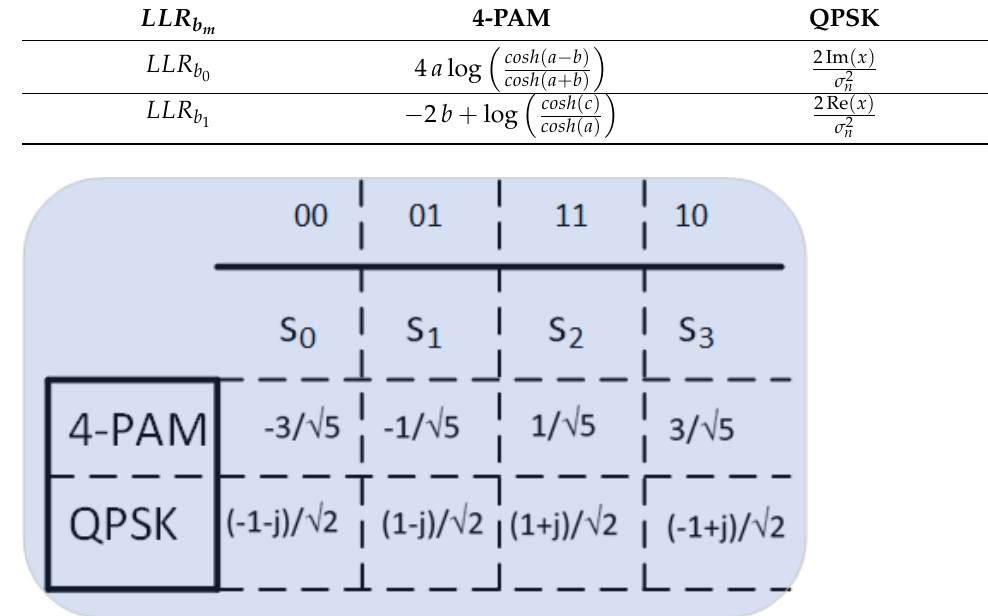
and LLR b of both 4-PAM and QPSK modulations. 0 1